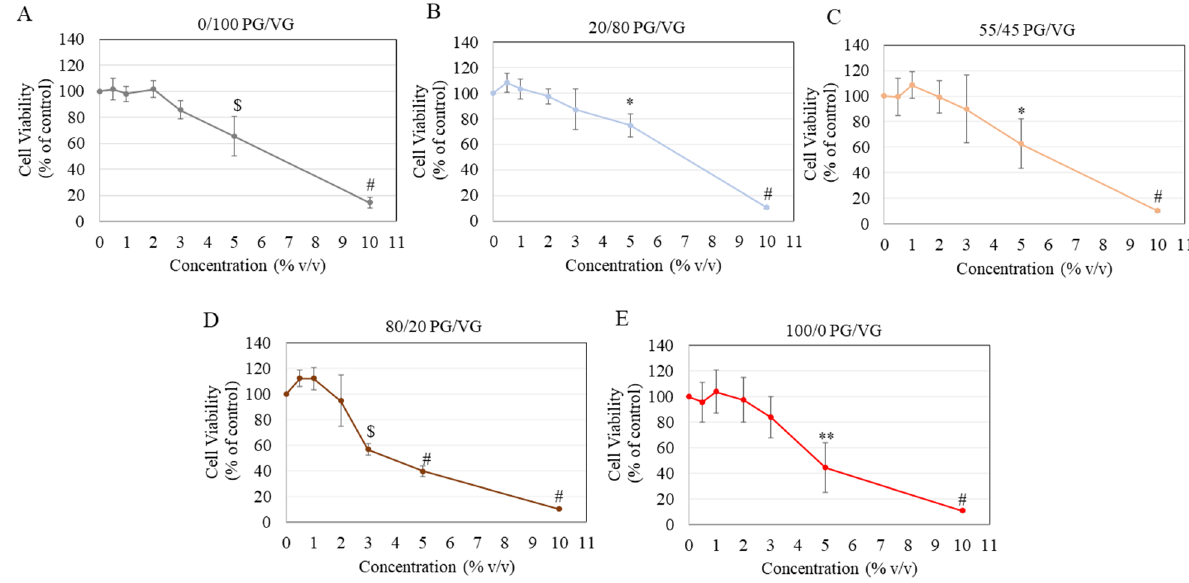
Figure 1. Viabilities of human melanocytes after 48 h exposure to e-liquids containing PG/VG at a ratio of ( A ) 0/100; ( B ) 20/80; ( C ) 55/45; ( D ) 80/20 and; ( E ) 100/0, at concentrations: 0, 1, 2, 3, 5, 10% v / v ; (One-way ANOVA with Dunnett’s post hoc test; * p < 0.05, ** p < 0.01, $ p < 0.001 and # p < 0.0001 vs. untreated control). All data is mean ± SD of at least three independent experiments.